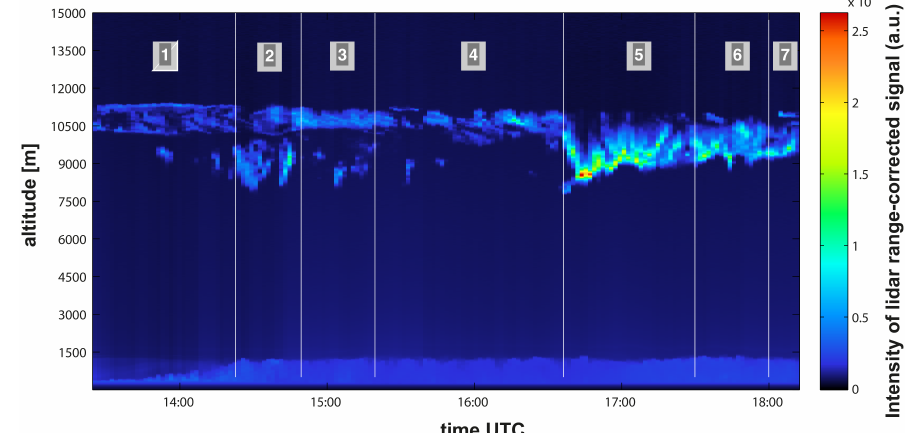
Fig. 1. A typical lidar range corrected signal display of the troposphere for 11 June 2007, when cirrus clouds were observed by the MPS-lidar (23 ◦ 33 0 S, 46 ◦ 44 0 W) over São Paulo City, Brazil. Note the aerosol backscattering layer up to 1km, while the cirrus clouds are detected between 8.0 and 11.5km. The stationary periods are represented by seven observational periods (also shown in Figs. 4 and 5) delimited by white vertical